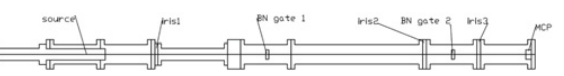
Figure 9. Sketch of an experimental setup at the ion source in the BoB lab.